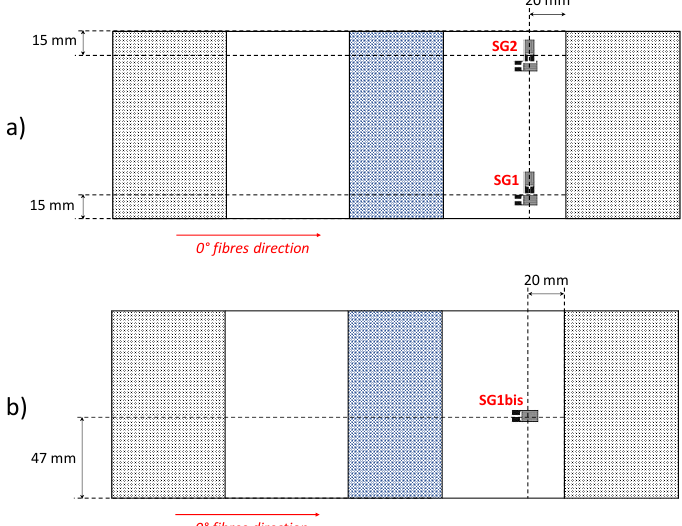
Figure 4. Strain gauges position in ( a ) TOUGH#1, TOUGH#2, MFB#1 and MFB#2 specimens; ( b ) TOUGH#3 and MFB#3 specimens.